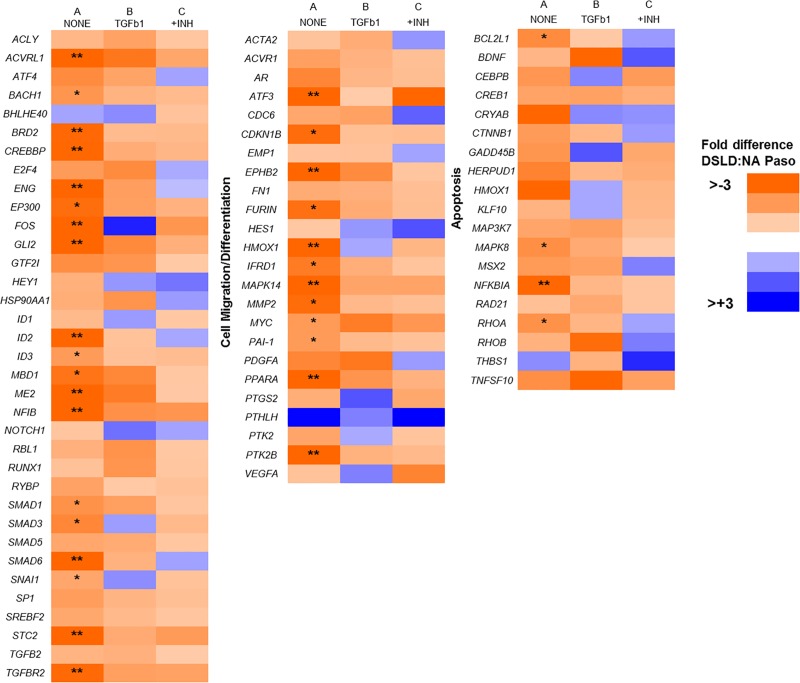
Heat map of fold-difference in transcript abundance of TGFβ signaling target genes in primary ADSC cultures from DSLD-Pasos and NA-Pasos.Statistical evaluation was performed as outlined in the Methods. Statistically significant decreases (p<0.05) in expression in DSLD Pasos is indicated: ** > 3 fold decreased; *1.5–3 fold decreased.